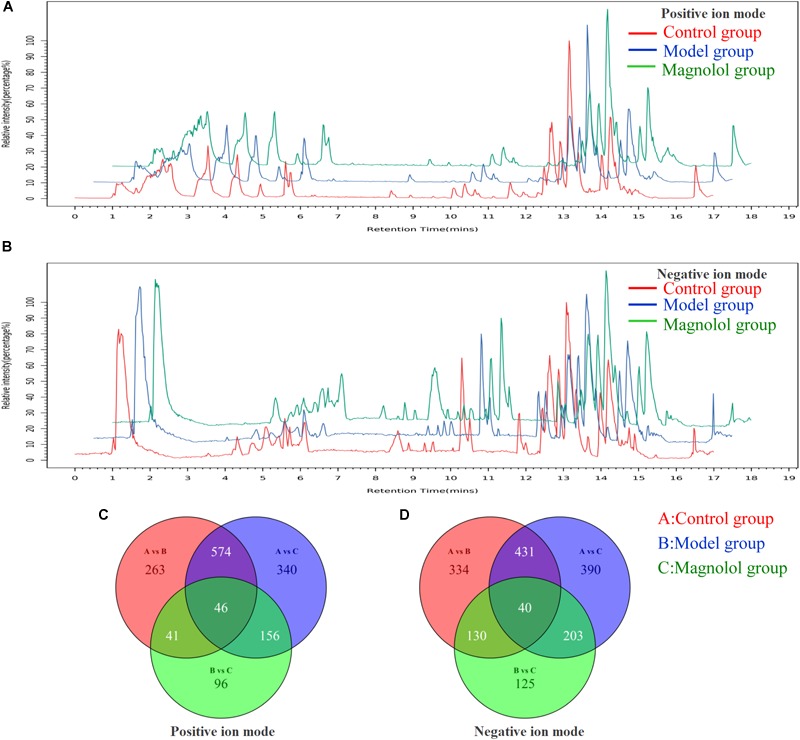
Typical sample base peak chromatogram and Venn diagrams. (A) Base peak chromatogram in positive ion mode. (B) Base peak chromatogram in negative ion mode. (C) Venn diagram in positive ion mode. (D) Venn diagram in negative ion mode.